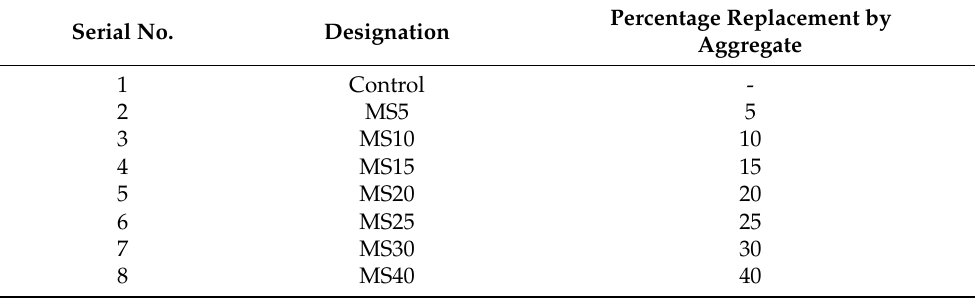
Percentage Replacement